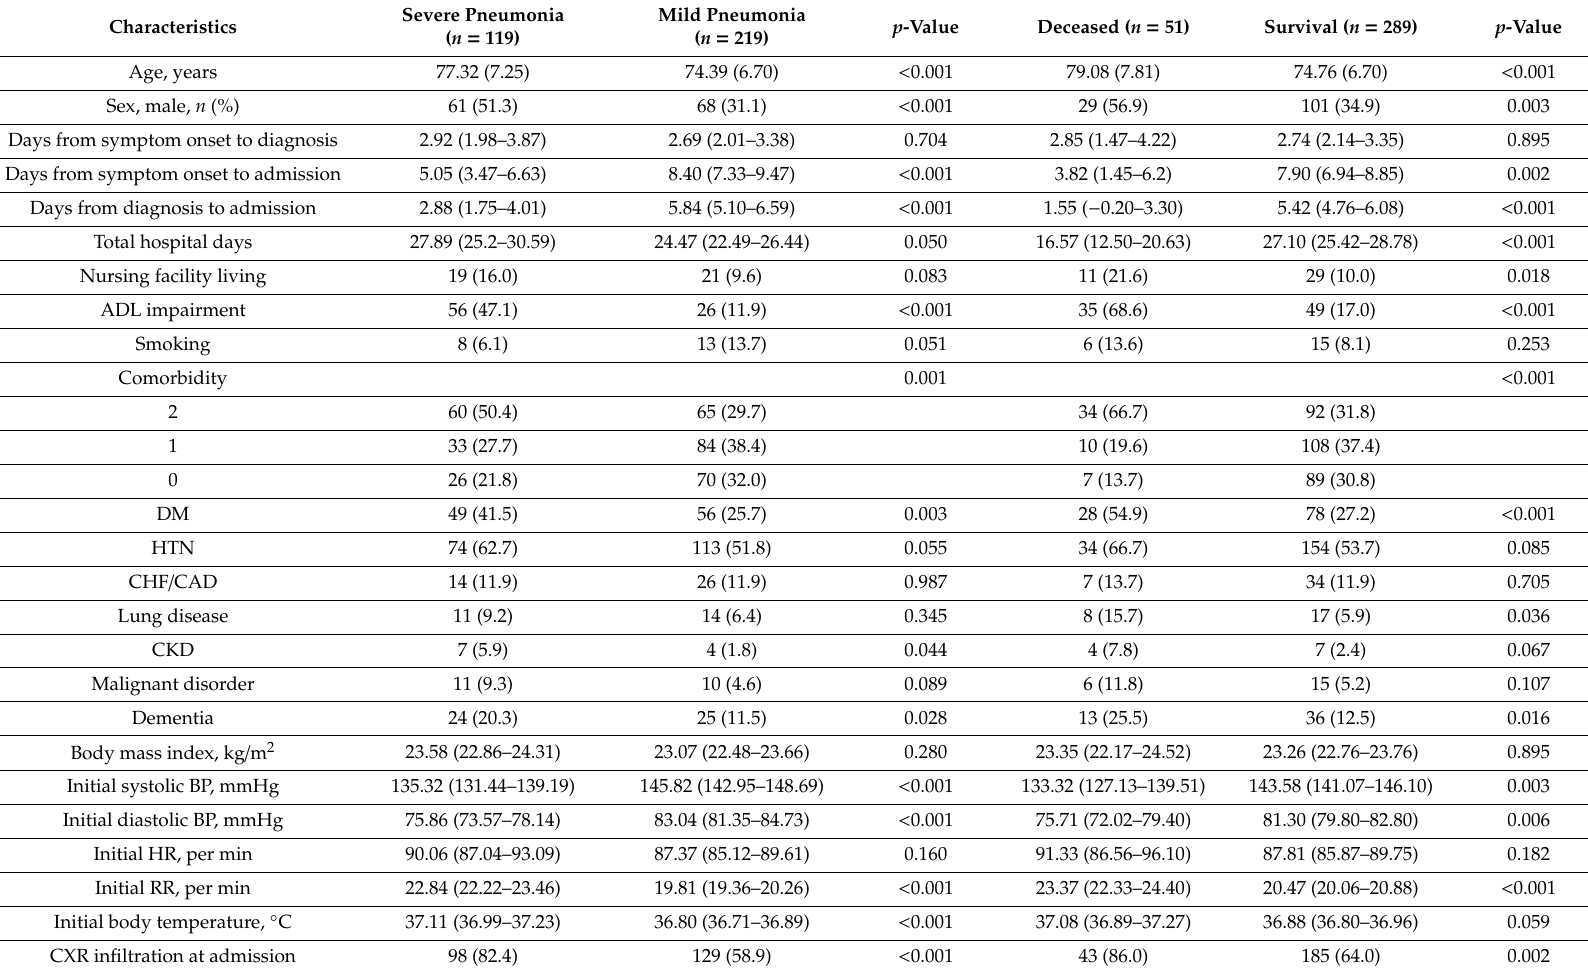
Table 1. Demographics and baseline characteristics between